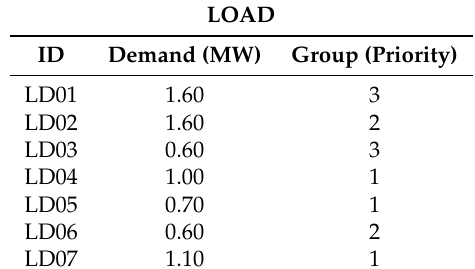
Table 2. Description of Load at Microgrid.